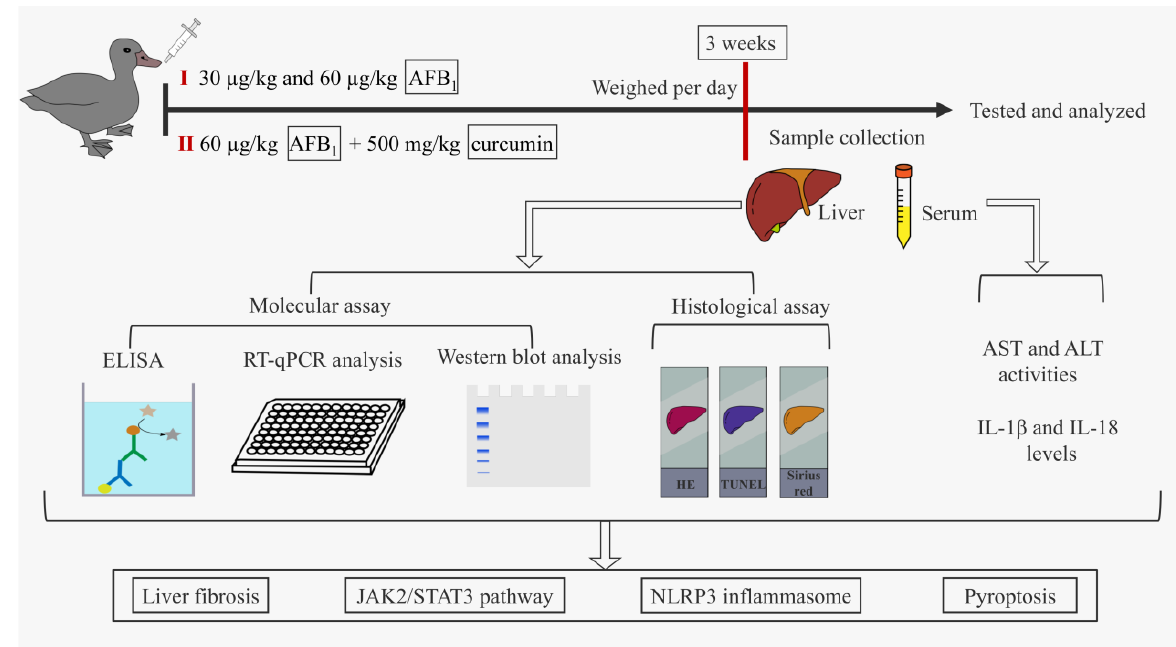
Figure 1. Schematic overview of experimental program. Firstly, ducks were exposed to a gradient dose of AFB 1 for 21 days. The effects of AFB 1 on fibrosis, JAK2/NLRP3 signaling pathway, and pyroptosis of duck livers were analyzed. Then, the dose of AFB 1 , which can cause significant liver fibrosis in ducks, was selected and treated with curcumin for 21 days. The effects of curcumin on fibrosis, JAK2/NLRP3 signaling pathway, and pyroptosis of duck livers caused by AFB 1 were analyzed.